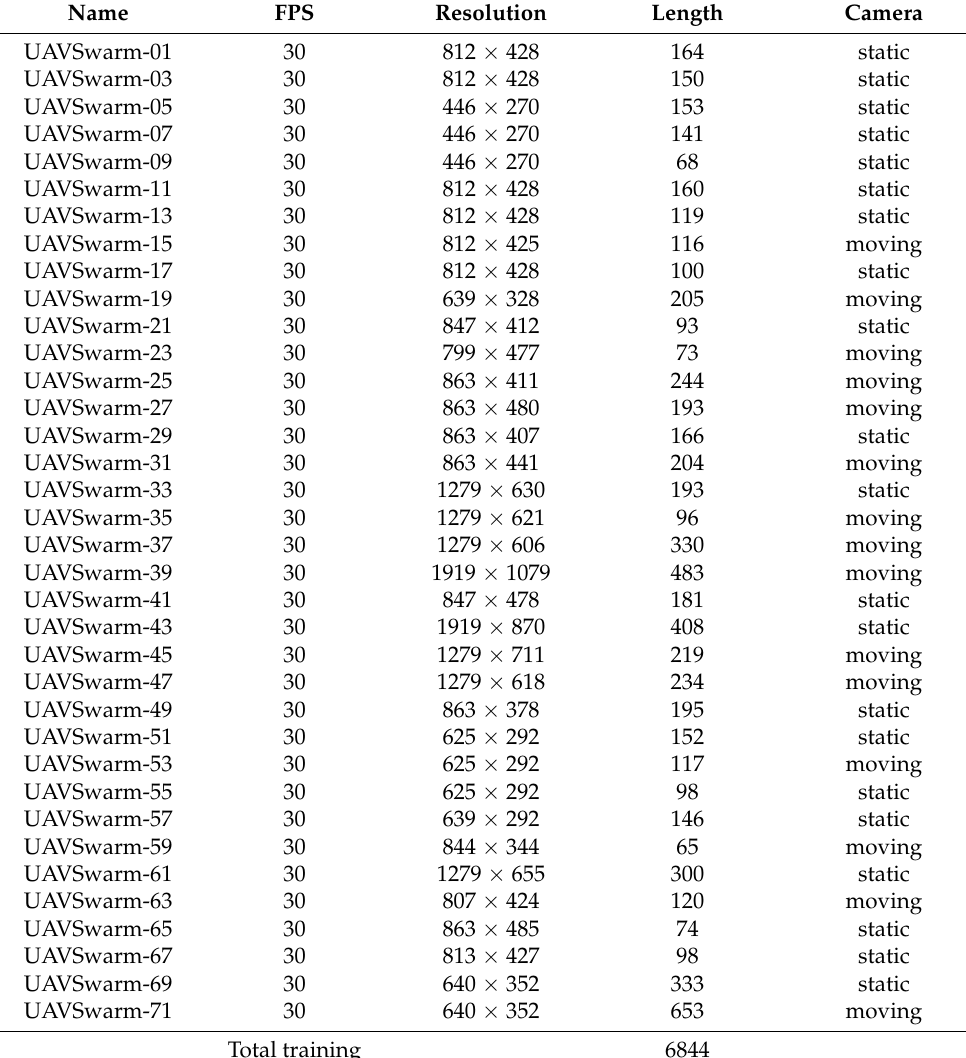
Table 1. Overview of the training sequences in the UAVSwarm dataset.